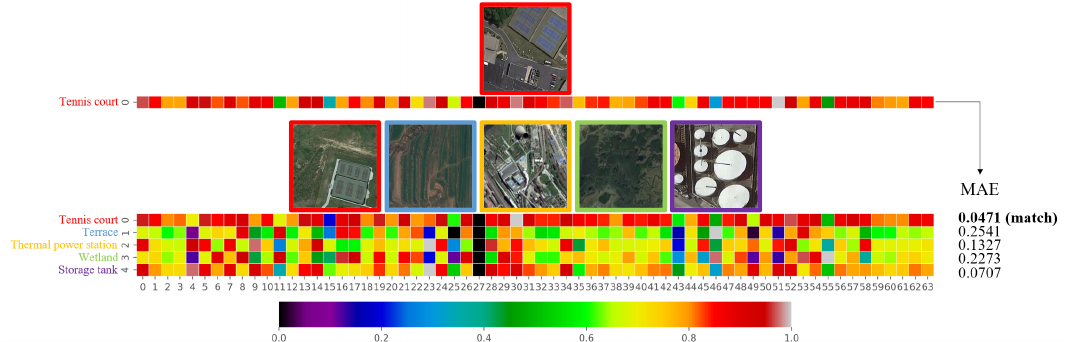
Figure 15. Comparison of channel attention features of a randomly selected query set image and support set images from a test set task on the NWPU-RESISC45